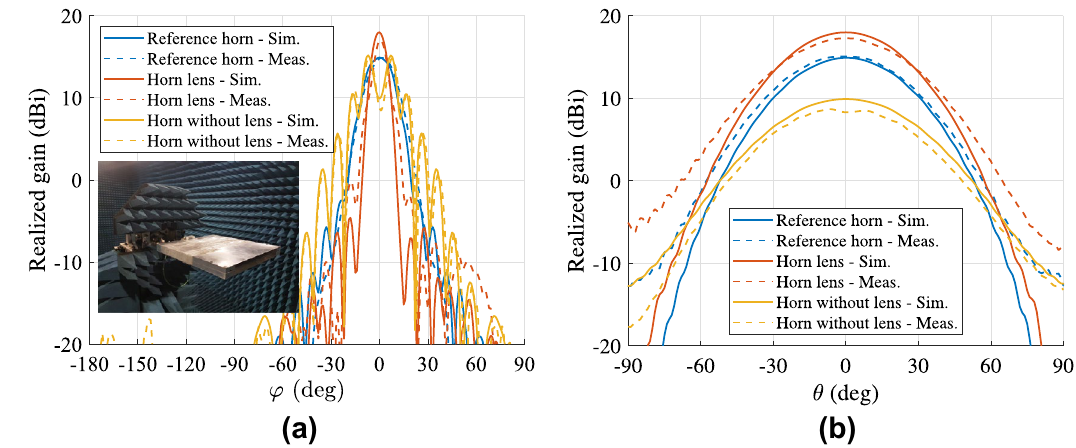
Figure 10. Simulated and measured far-field of ( a ) H-plane ( θ = 90 ◦ ), and ( b ) E-plane ( ϕ = 90 ◦ ) at 15 GHz for the horn lens antenna, profiled horn antenna without lens, and the reference antenna. The dimensions are L L = L H = 207 mm, W L = W H = 167 mm, H L = H H = 20 mm, and F L = 40